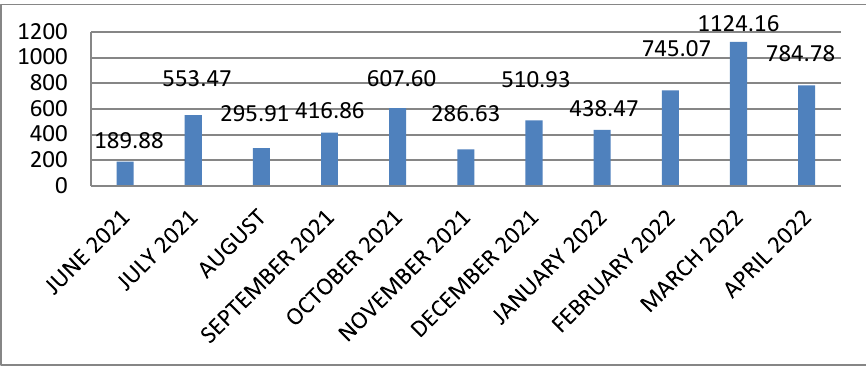
Figure 2. Mean titers of antibodies (Bau/mL) depending on the month of onset. Table 1. Median and mean titers of anti-SARS-CoV-2 antibodies depending on age. Median Titers of Anti-SARS-CoV-2 Mean Titers of Anti-SARS-CoV-2 Age Antibodies (Bau/mL) Antibodies (Bau/mL) 0–1 years 252.00 437.04 350.00